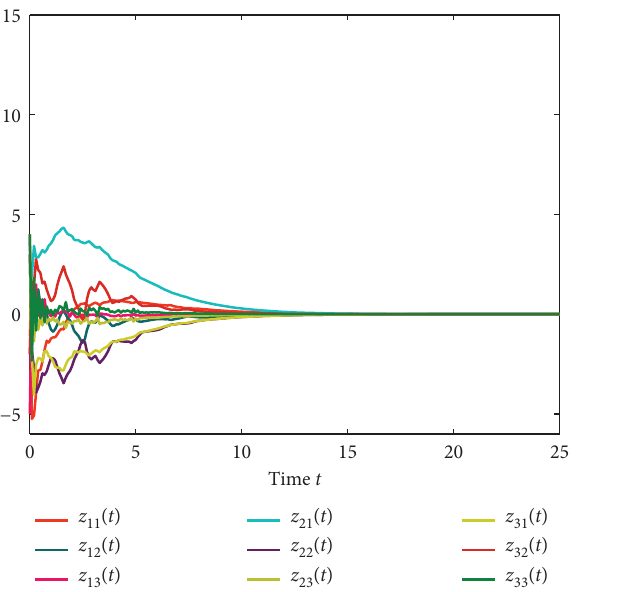
Figure 9: Trajectories of state system with control inputs.